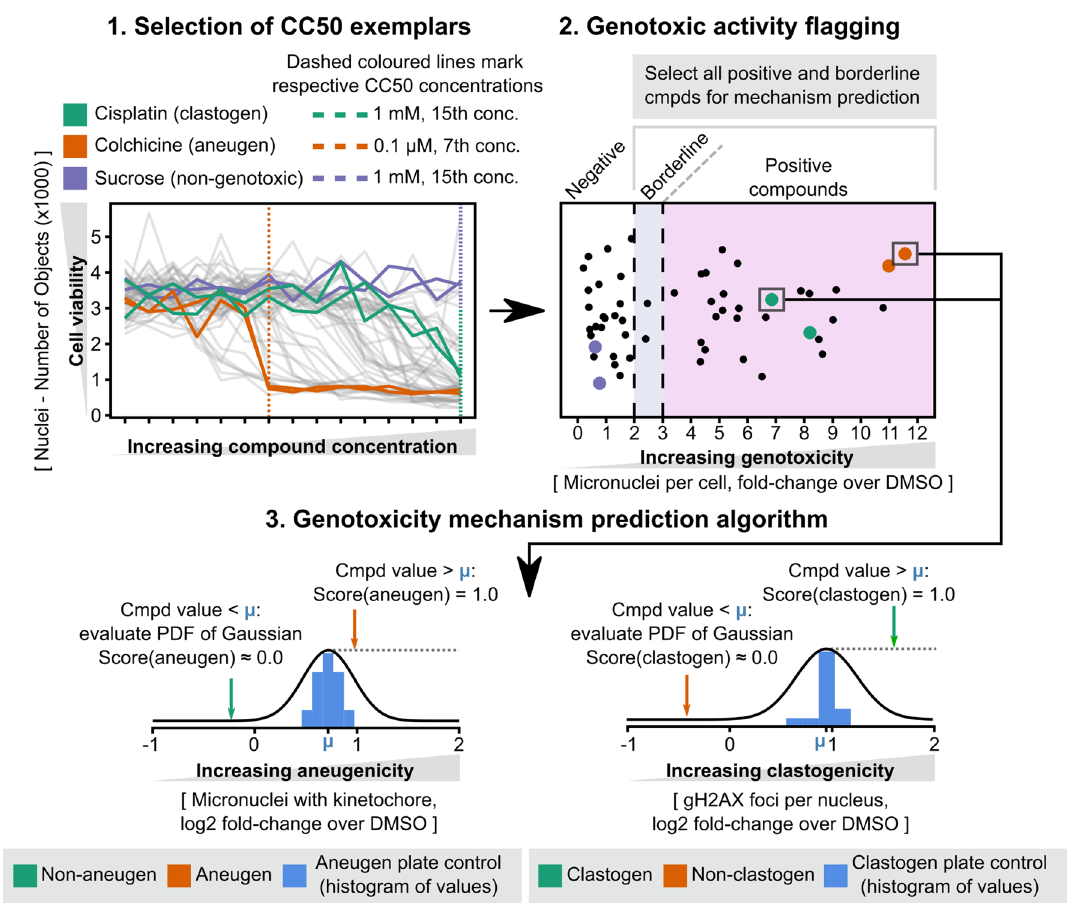
Figure 3. Statistical analysis workflow for automated prediction of genotoxicity for validation compounds. (1) Section of CC50 exemplars: the first concentration at which a greater than 50% reduction in cell number is observed or in the case of no cytotoxicity the highest concentration, is selected. Highlighted are Colchicine (Orange:0.1uM), Cisplatin (Green: 1 mM) and Sucrose (Purple: 1 mM). (2) Genotoxicity flagging: the frequency of micronuclei compared to average inter-pate DMSO control for each validation compound is shown, compounds with ≥ 2–< 3-fold increase in micronuclei are flagged as borderline and compounds > 3-fold increase in micronuclei classed as positive. Highlighted are replicate responses of Colchicine (Orange), Cisplatin (Green) and Sucrose (Purple). (3) Genotoxicity mechanism prediction. Gaussian distribution of inter-plate aneugen and clastogen control well responses for ( a ) the proportion of micronuclei with a kinetochore and ( b ) number of H2AX foci/nucleus respectively are plotted, responses for colchicine (orange: aneugen) and cisplatin (green: clastogen) are represented on these